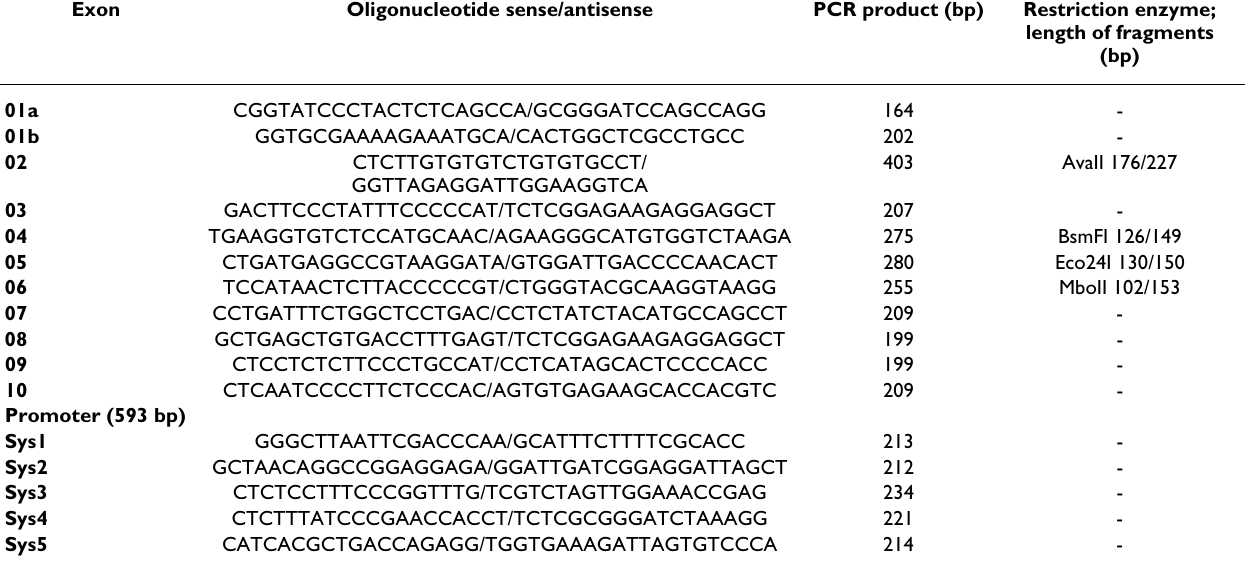
Table 1: Oligonucleotides and restriction enzymes used for SSCP analyses of the exonic and 593 bp promoter regions of the RXRB gene. Exon Oligonucleotide sense/antisense PCR product (bp) Restriction enzyme;